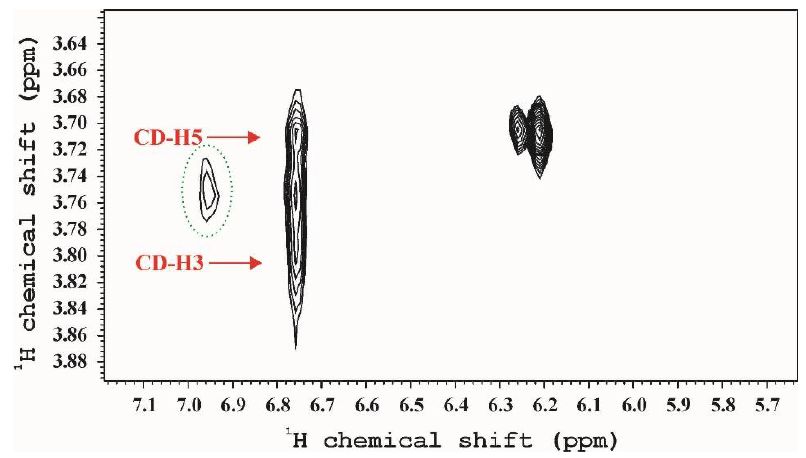
Figure 4. ROESY spectrum of γ -CDcurcumin complex. The green ellipsoid notesthe trivial cross peak between methoxy group and ‘d’ hydrogen of curcumin. Table 4. Relative amount of curcumin to CD on the base of IR intensity ratio of two characteristic